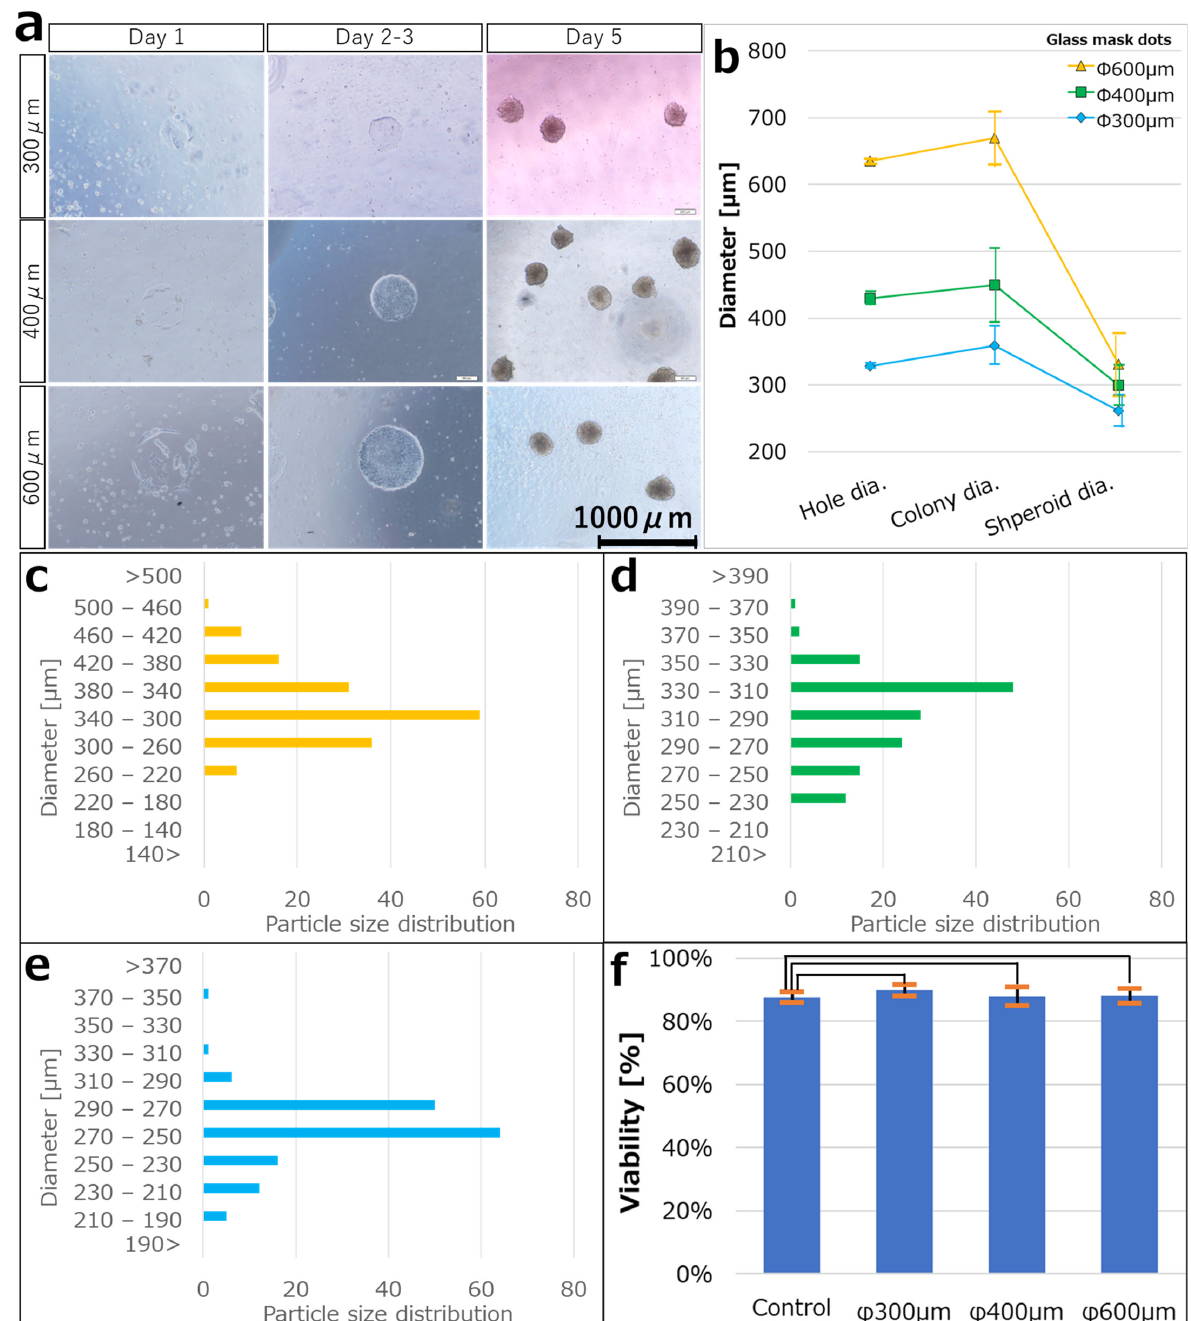
Figure 4. ( a ) Bright-field images for each day after seeding hiPSCs on iMatrix-coated substrates of each dot size (300 µ m, 400 µ m, and 600 µ m). The hiPSCs adhered to the substrate on day 1 and proliferated into colonies of the same size as the iMatrix pattern on days 2–3, and the colonies dissociated from the substrate on days 3–4. The colonies were then incubated in a three-dimensional suspended state, and spheroids were formed on day 5. ( b ) The average diameter of the dot patterns during each step. Error bars indicate the standard deviation. Particle size distribution of spheroids produced at patterns of ( c ) 300 µ m (N = 155), ( d ) 400 µ m (N = 145), and ( e ) 600 µ m (N = 158). ( f ) Viability confirmation by trypan blue staining. Student t-test was performed to compare survival rates between the 2D colonies and the spheroids ( p = 0.05). p < 0.05 was considered statistically significant. Data are expressed as means ± standard deviations. The relationships were not statistically significant in all of these